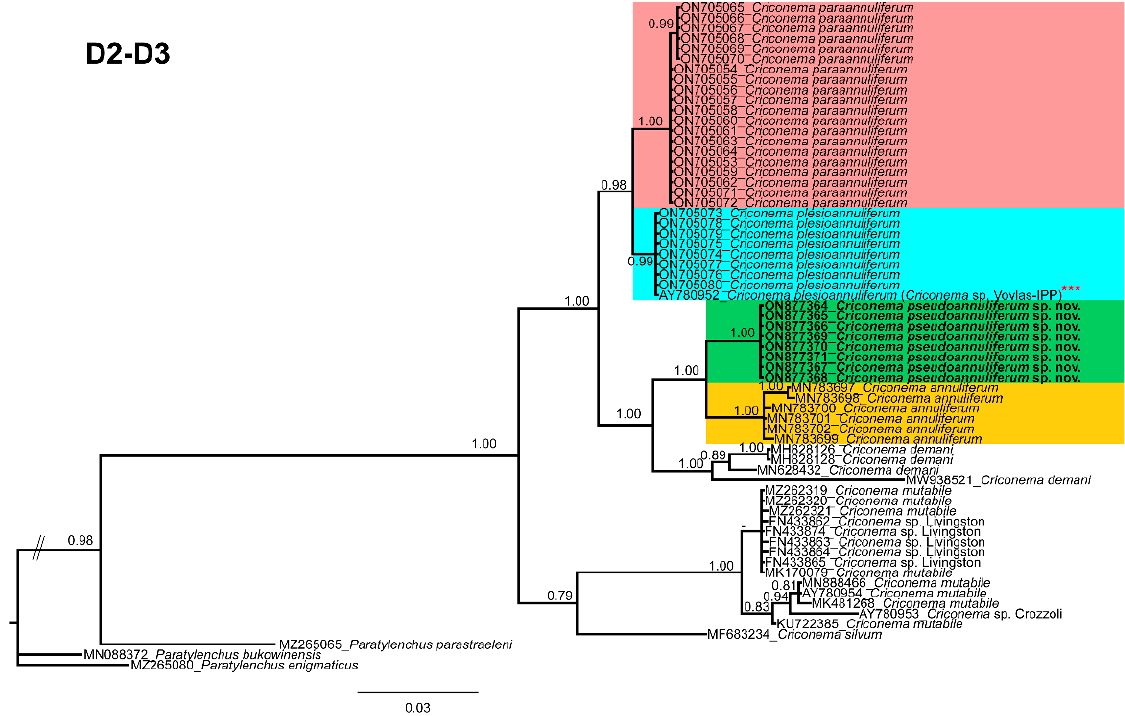
Figure 7. Phylogenetic relationships within the genus Criconema . Bayesian 50% majority rule con- sensus tree as inferred from D2-D3 expansion domains of the 28S rRNA sequence alignment under transition model with invariable sites and a gamma-shaped distribution (TIM3 + I + G). Posterior probabilities of more than 0.70 are given for appropriate clades. Newly obtained sequences in this study are shown in bold. The scale bar indicates expected changes per site, and the coloured boxes indicate the clade association of Criconema annuliferum complex. *** Initially identified in NCBI as Criconema sp. Vovlas-Italy.